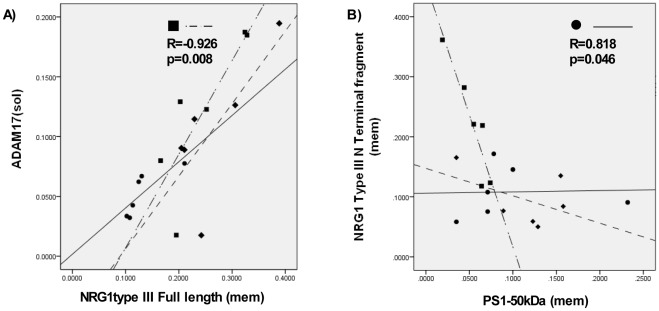
Pearson’s correlation analyses between levels of Neuregulin 1 (NRG1) and NRG1 cleavage enzymes in Brodmann’s area 9 (BA9).A) ADAM17 and NRG1 full length; B) NRG1 NTF and PS1-50 kDa. Controls (•, —); SCZ (▪, •—•); BPD (♦, –-). Inset shows R and p values for the statistically significant cohort (represented by symbol) for each plot.